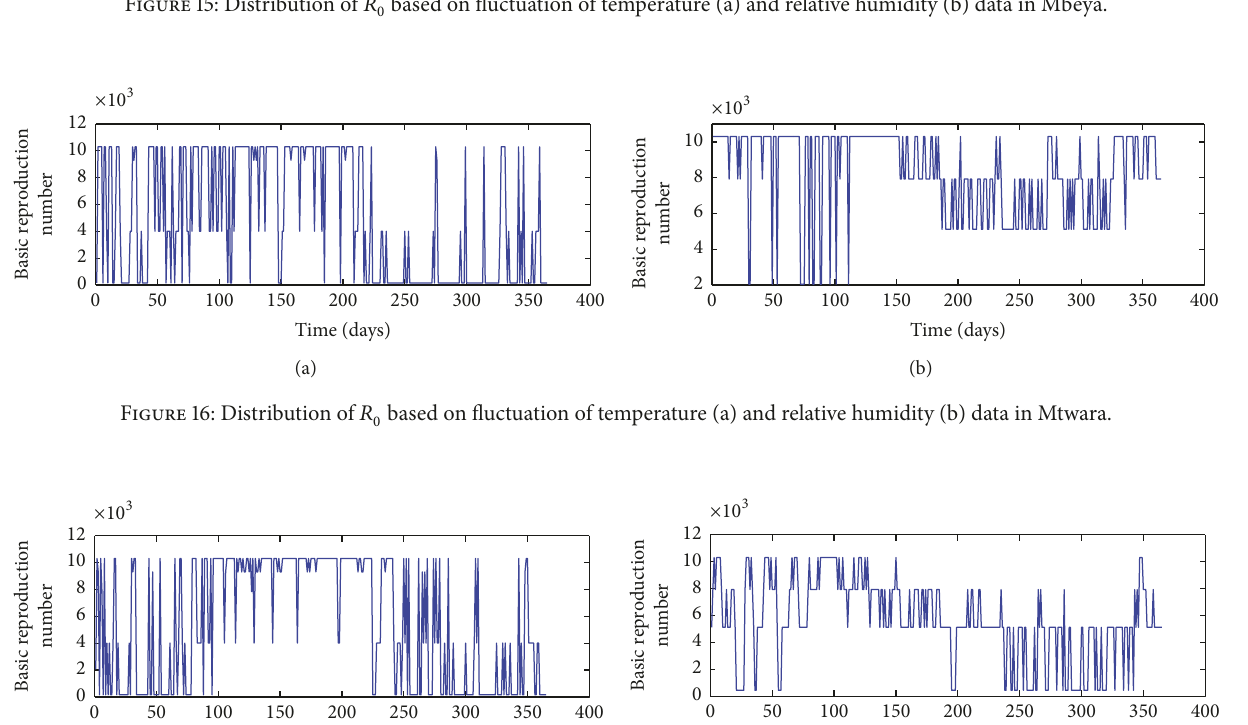
Figure 15: Distribution of 𝑅 0 based on fluctuation of temperature (a) and relative humidity (b) data in Mbeya.